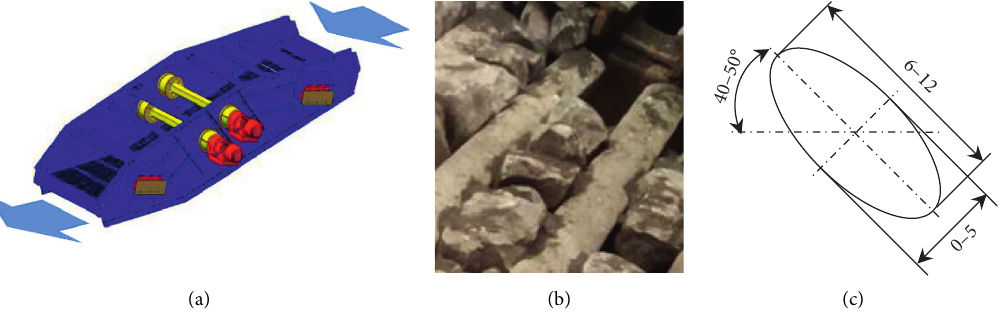
Figure 1: Vibrating screen (mifama.com.pl) (a); blinding with a near mesh size material (b); orbit of motion